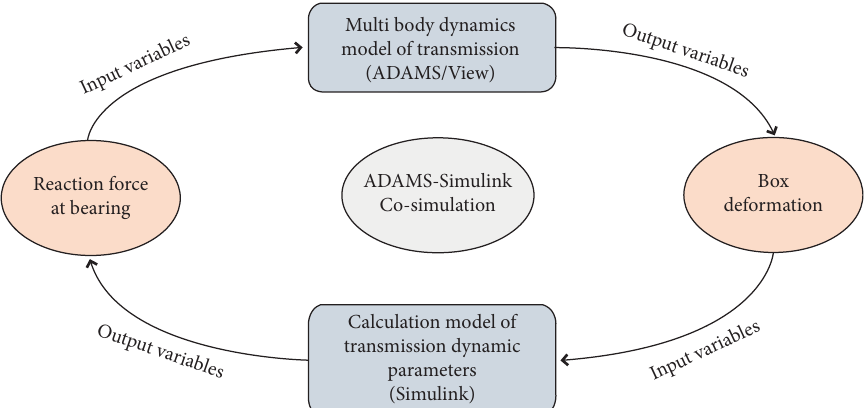
Figure 13: Schematic diagram of